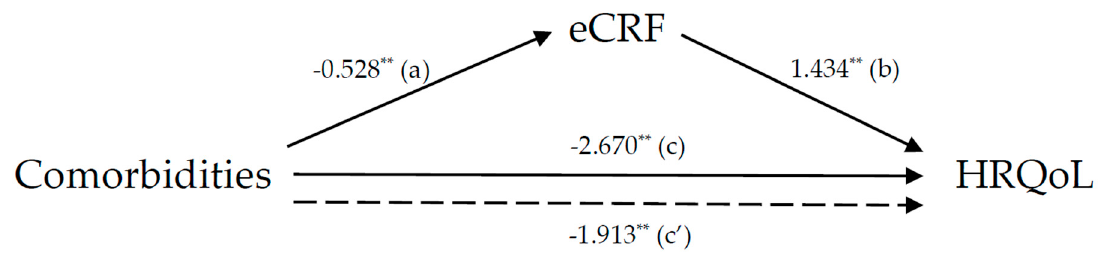
Figure 1. Mediation analysis. Path coefficients of comorbidities on health-related quality of life (HRQoL) through non-exercise based estimation of cardiorespiratory fitness (eCRF). ** indicates statistical significance at p < 0.001 for all the paths.